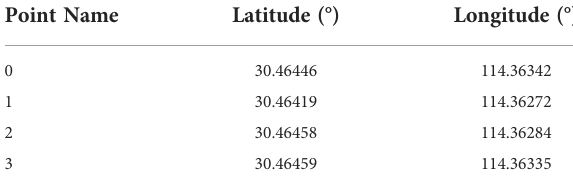
TABLE 6 Simulation test irregular fi eld plot contour pointinformation.